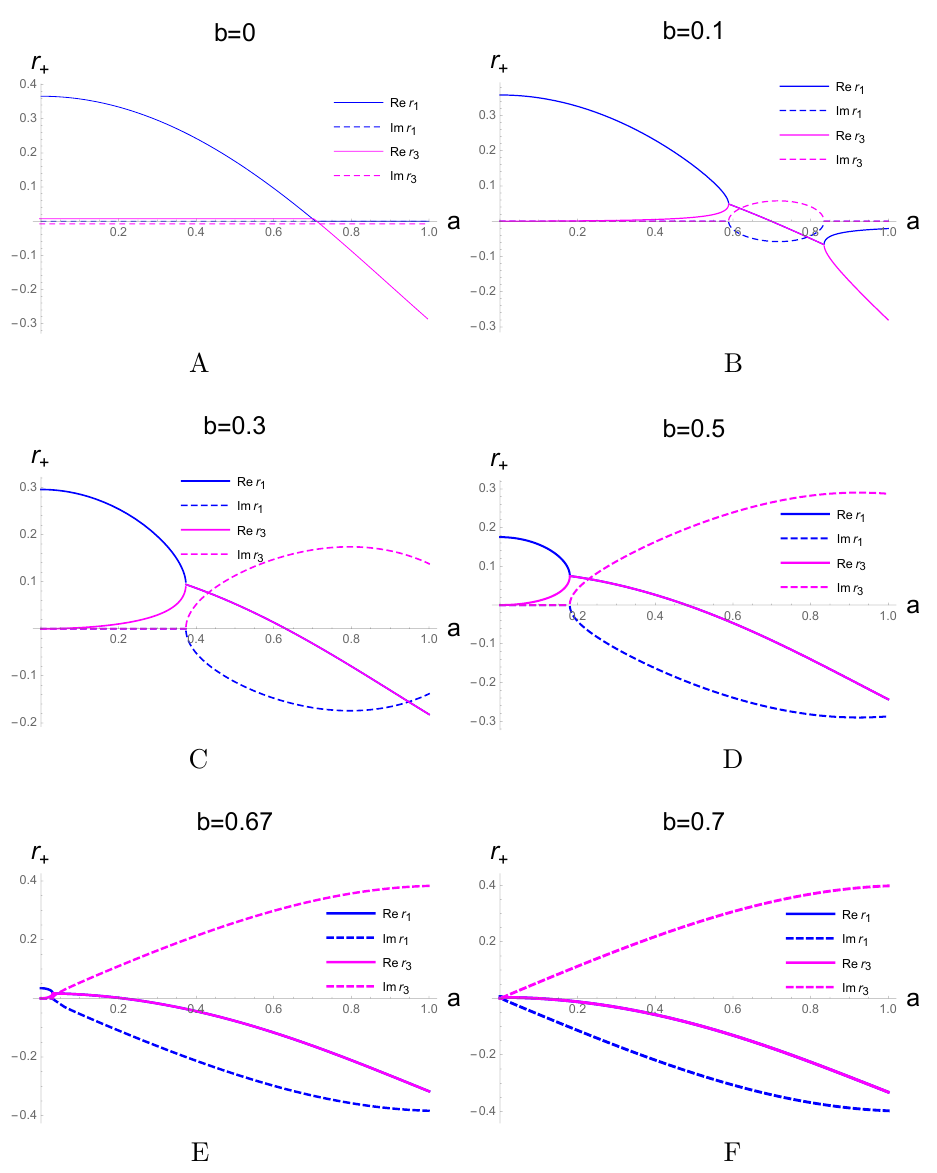
Figure 3 . 3 roots of equation ∆( r ) = 0 vs a for varieties of b . We see that only the first root can be positive for a < a ( b ) . Here M is taken to be 0 . 25 and ‘ = 1